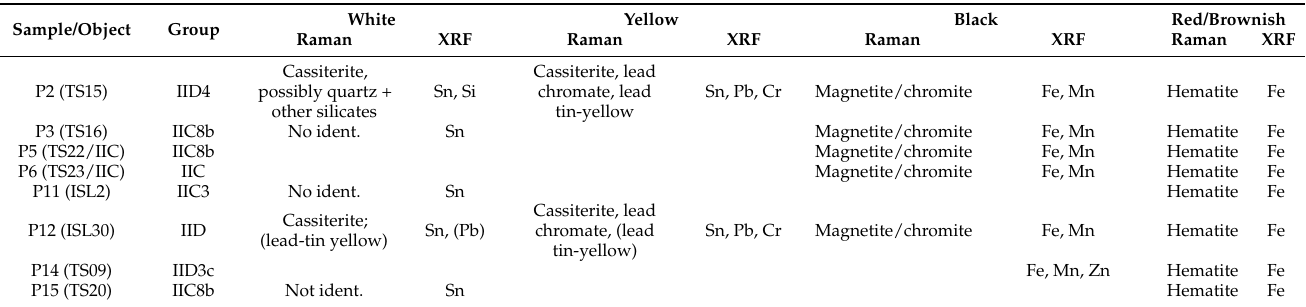
Figure 9. Details of XRF analyses. ( Left ) White onglaze decoration on P2 (TS15). ( Right ) Yellow on a black decoration on P12 (ISL30). Table 10. Results of the analysis of onglaze